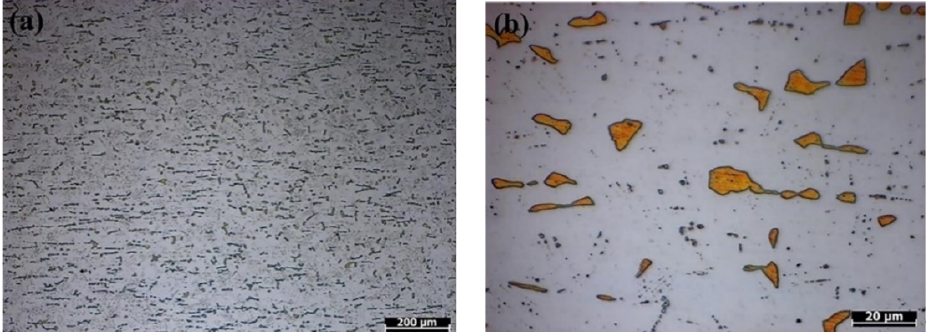
Figure 2. Metallographic images showing the distribution ( a ) and size of the sigma Fe-Cr precipitates ( b ).